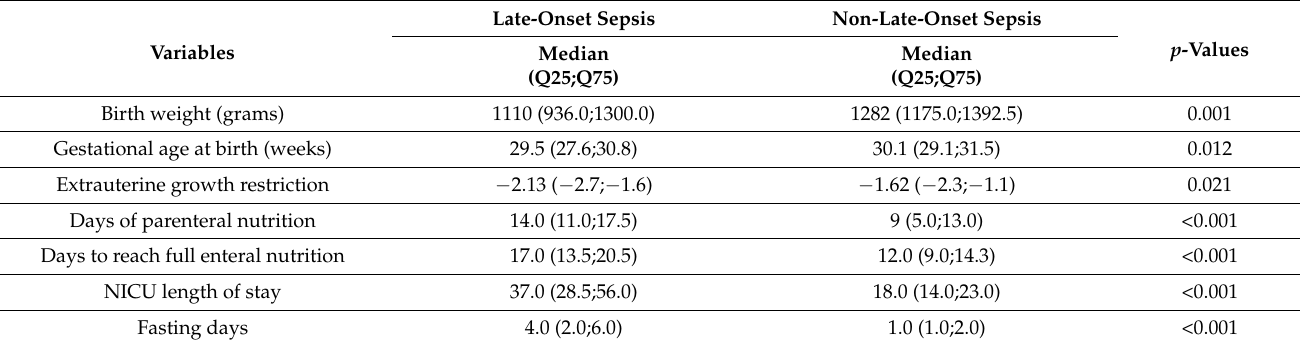
Table 1. Quantitative variables associated with late-onset sepsis ( n =